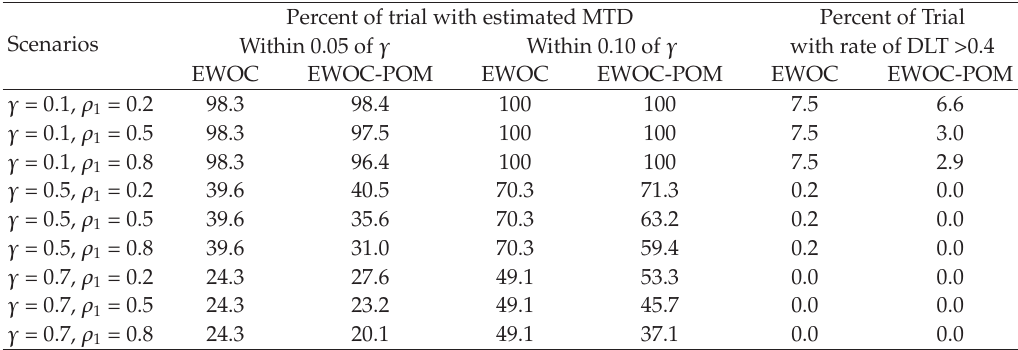
Table 1: Percent of trials with estimated MTD within 5% of the dose range and 10% of the dose range of the true MTD γ and percent of trials for which the rate of DLT exceeds 40% for EWOC and EWOC-POM under the nine